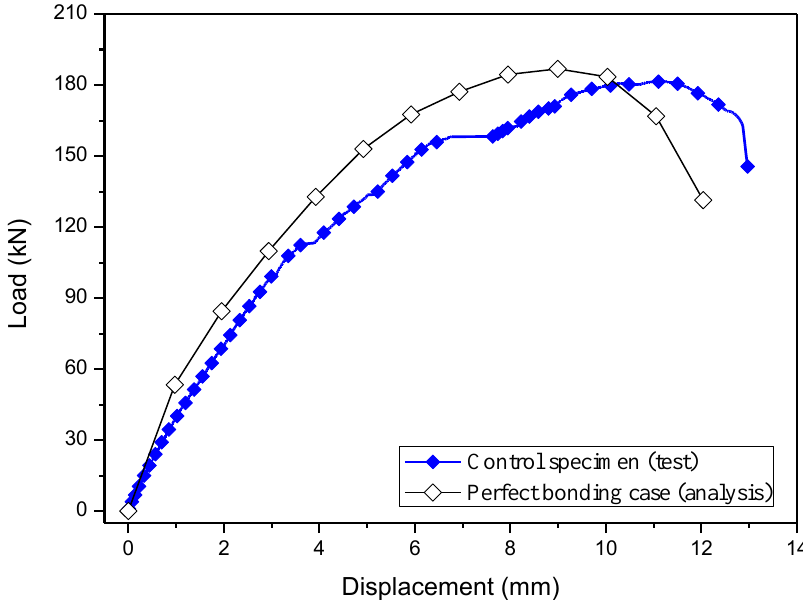
Figure 17. Comparison between test and analysis results of shear beam specimen. Table 4. Analysis results for each shear